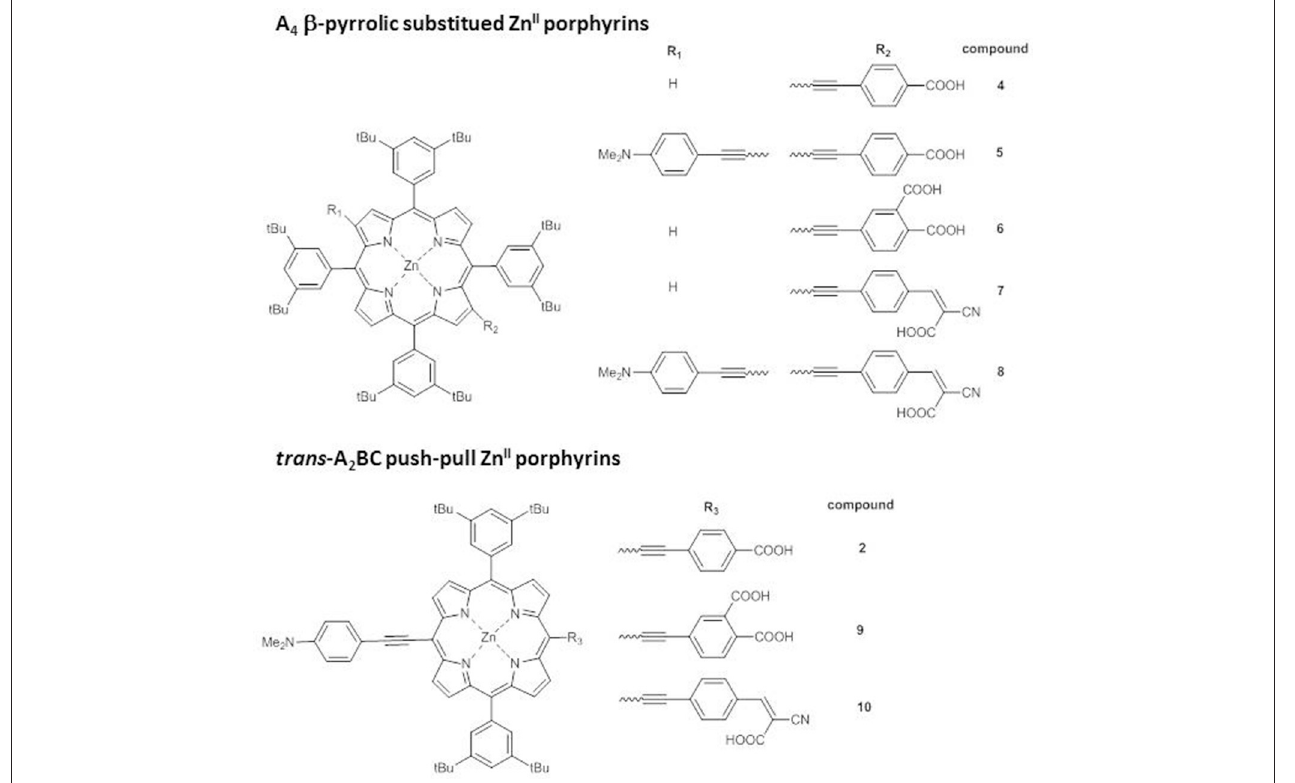
FIGURE 4 | A 4 β -pyrrolic Zn II porphyrins 4-8 and trans -A 2 BC push-pull Zn II porphyrins 9-10